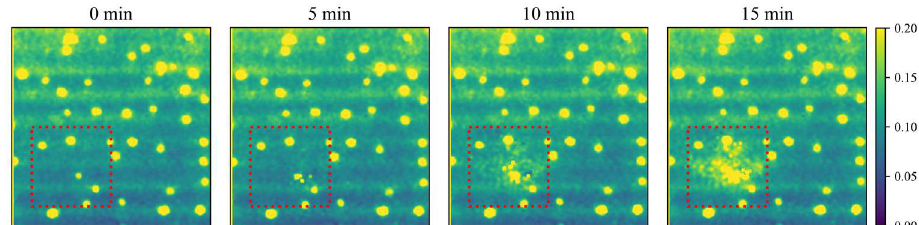
Figure 6. Performance metrics for different models in the phantom experiment for reduced scatter- ing coefficient.